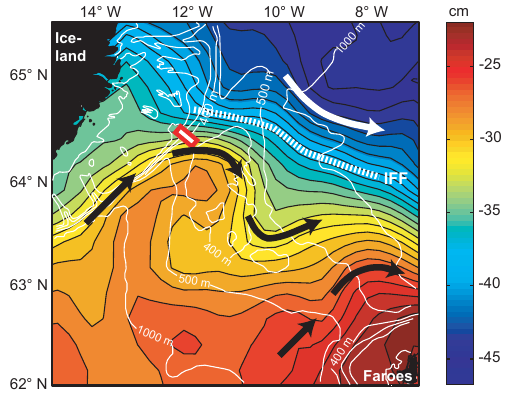
Figure 3. The mean dynamic topography (background colours) above the IFR according to altimetry data from the Copernicus Ma- rine Environment Monitoring Service (CMEMS) (Sect. 2.3). Iso- baths are shown by thin white lines for every 100m down to 500m and for 1000m depth. Black arrows indicate the two main Atlantic inflow regions over the IFR. The white arrow indicates the surface circulation of the Norwegian Sea. The thick hatched white line in- dicates the Iceland–Faroe Front (IFF). The red rectangle marks the deployment sites of our field experiment.